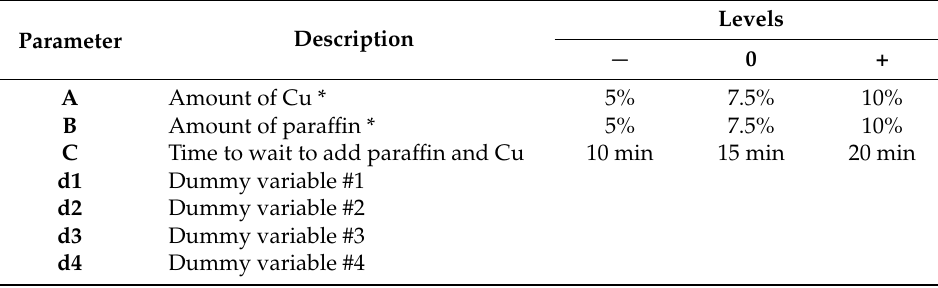
Table 2. Parameters description for Plackett-Burman